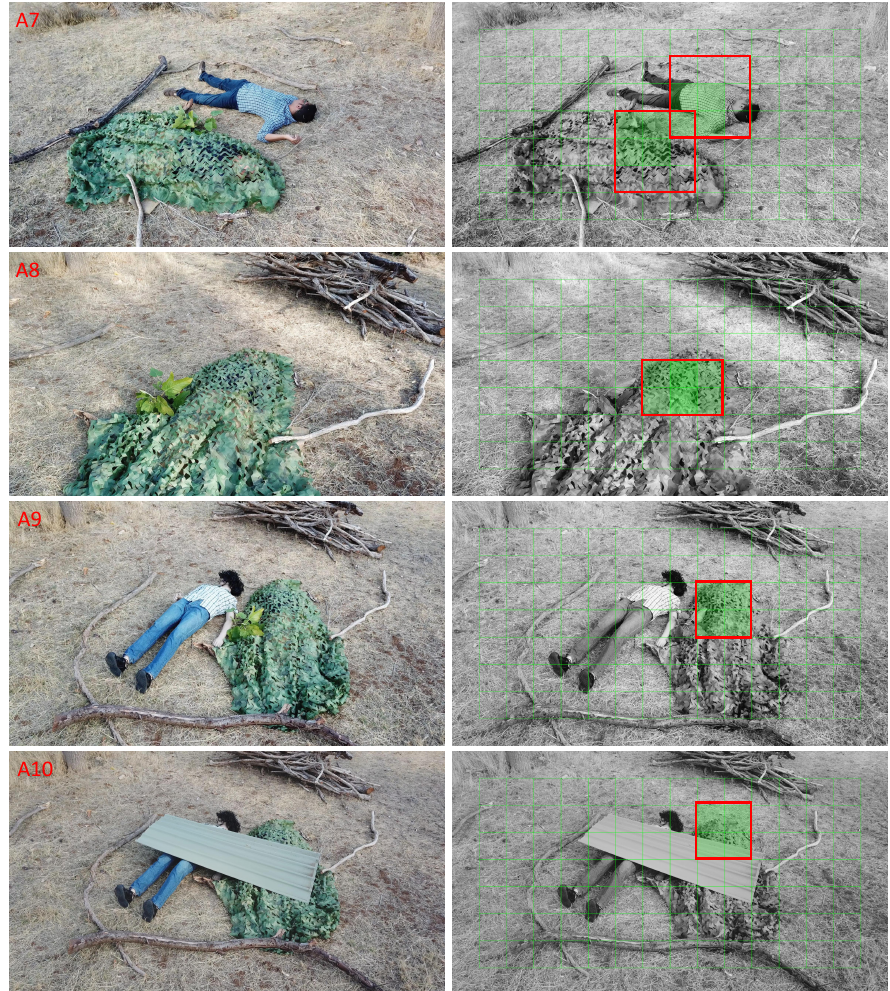
Figure 7. Aerial videos A7–A10. In these videos, the human subject was covered with a camouflage net. The simulated scenarios were A7: a camouflaged person and clearly visible person, A8: a person covered with a camouflaged net, A9: a camouflaged person and a mannequin and A10: a camouflaged person and mannequin partly covered with a sheet metal. A1–A6 are shown in Figure